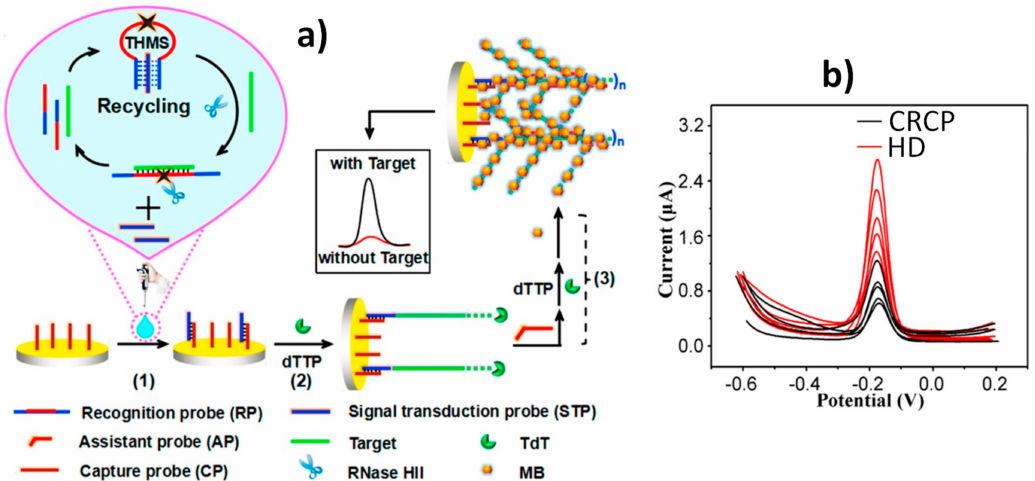
Figure 1. ( a ) Schematic illustration of the biosensor developed for the detection of KRAS G12DM ss-ctDNA involving the use of a THMS probe and TdT and Rnase HII dual amplification. ( b ) DPV traces recorded with the developed biosensor in the analysis of DNA extracted from plasma samples of 5 HDs and 5 CRCPs. Reprinted and adapted from [20] with